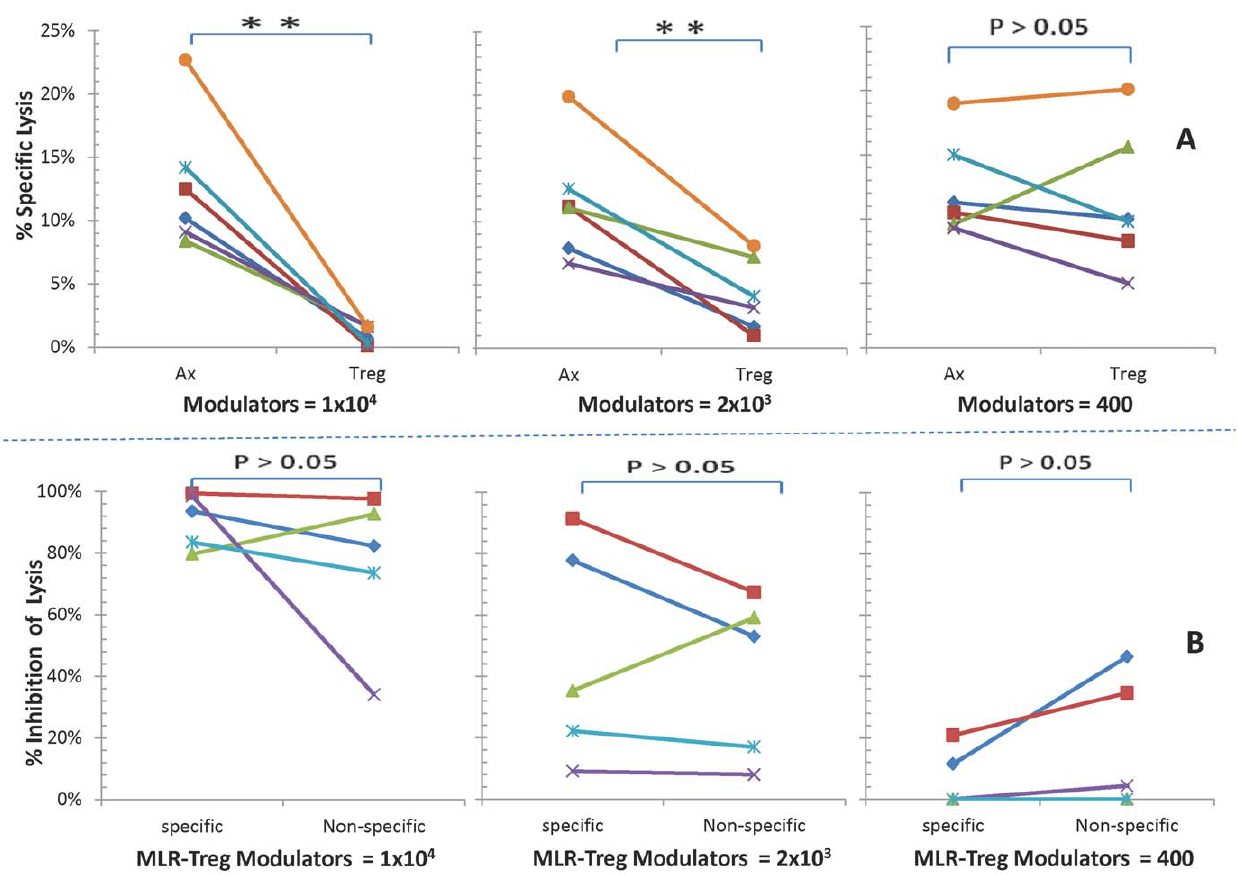
Figure 5. Regulatory effects of MLR-Tregs in micro-CML assays of responding purified CD8 + cells. Micro-CML inhibition assays were performed as described in Figure 4, except that 5 6 10 4 purified CD8 + cells rather than whole PBMC (1 6 10 5 ) were used as responders. The data are depicted as: (A) Percent specific lysis: against the specific stimulator used both in MLR-Treg generation and the micro-CML readout. Similar to the data in Figure 4A, the lysis of target cells was decreasingly inhibited by decreasing concentrations of MLR-Tregs (**=p , .01; n=6). (B) Percentage inhibition: the percent specific lysis values were converted to percent inhibition. In contrast to the findings depicted in Figure 4B, inhibition of purified responding CD8 + CTL activity did not appear to be as clearly allospecific, i.e. there was a lack of significant differences between the points on the right side vs the left side of each graph in the lower row (p . 0.05; n=5).